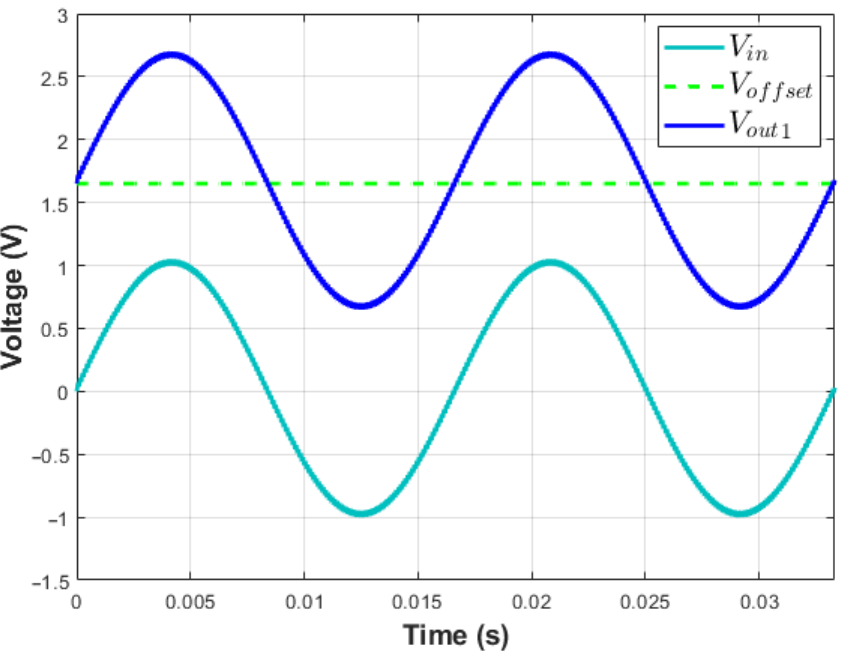
Figure 8. Simulation of the conditioning circuit of the current